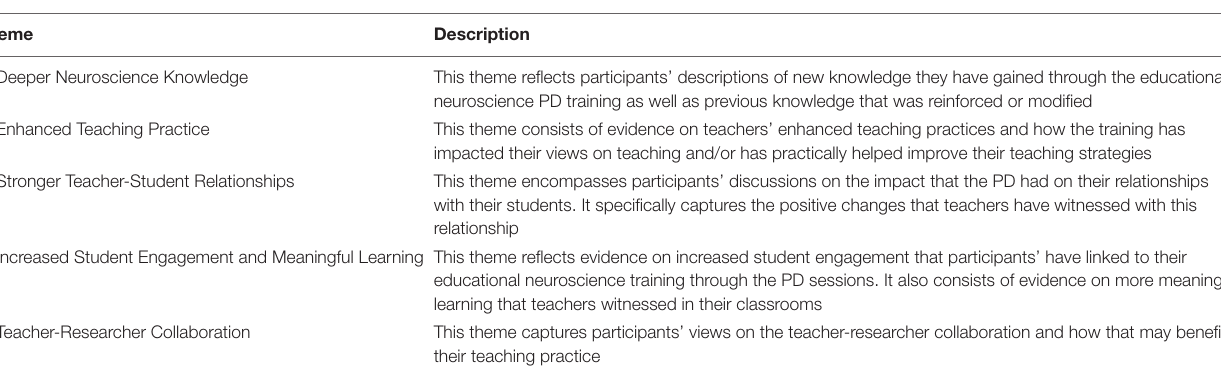
TABLE 1 | Resulting themes of thematic